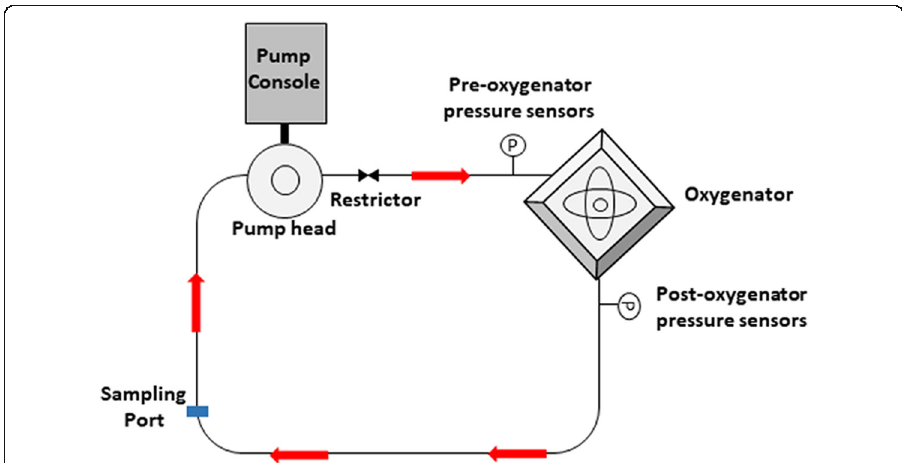
Fig. 1 Schematic diagram of ex-vivo ECMO model